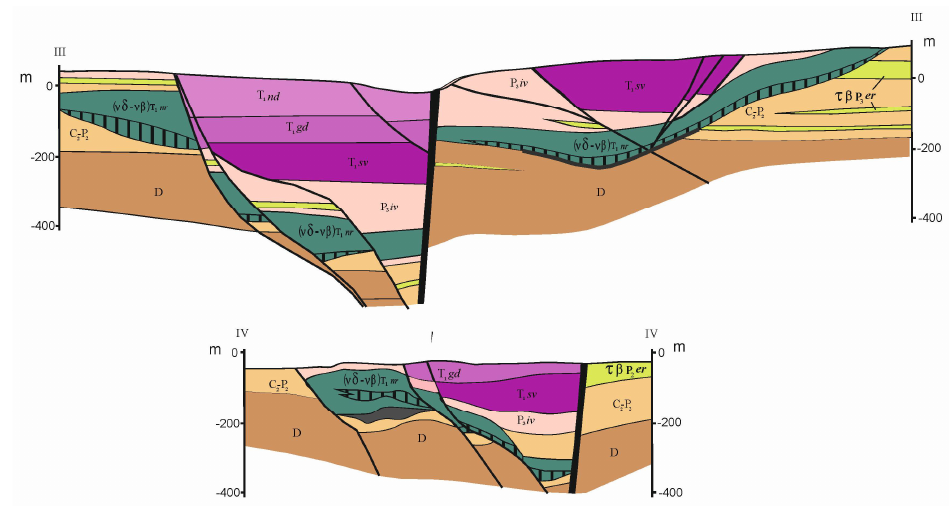
Figure 4. Cross-sections III-III and IV-IV of the Talnakh branches (based on authors data and after Likhachev [5]). Captions in Figure 3.